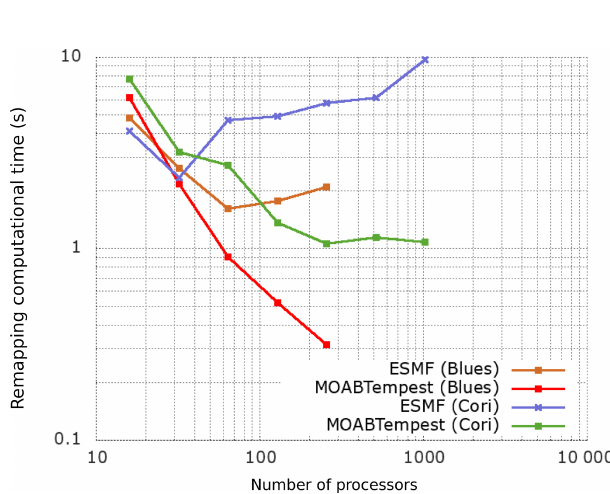
Figure 11. CS ( E = 614400 quads) → CS ( E = 153600 quads) remapping (-m conserve) on LCRC/ALCF and NERSC